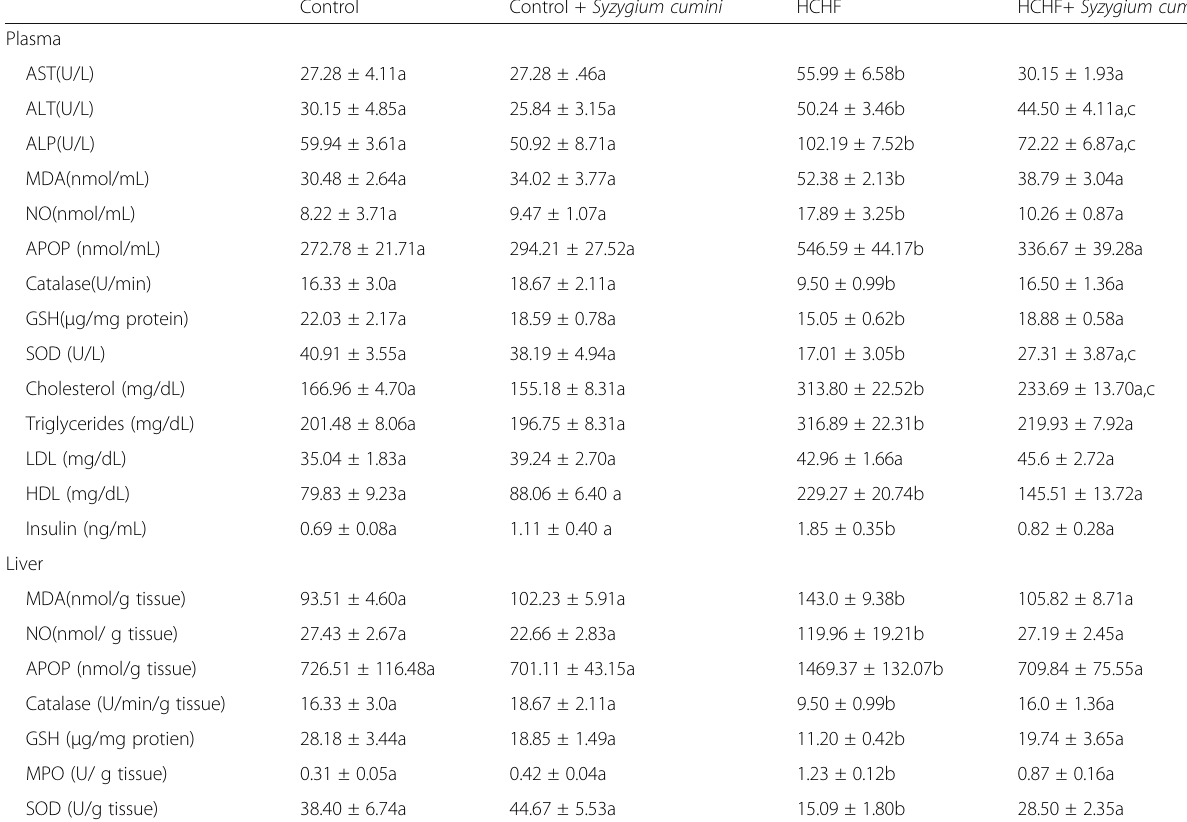
Table 4 Effects of high fat diet and Syzygium cumini seed powder supplementation on various biochemical parameters in plasma and liver of diet induced obese rats